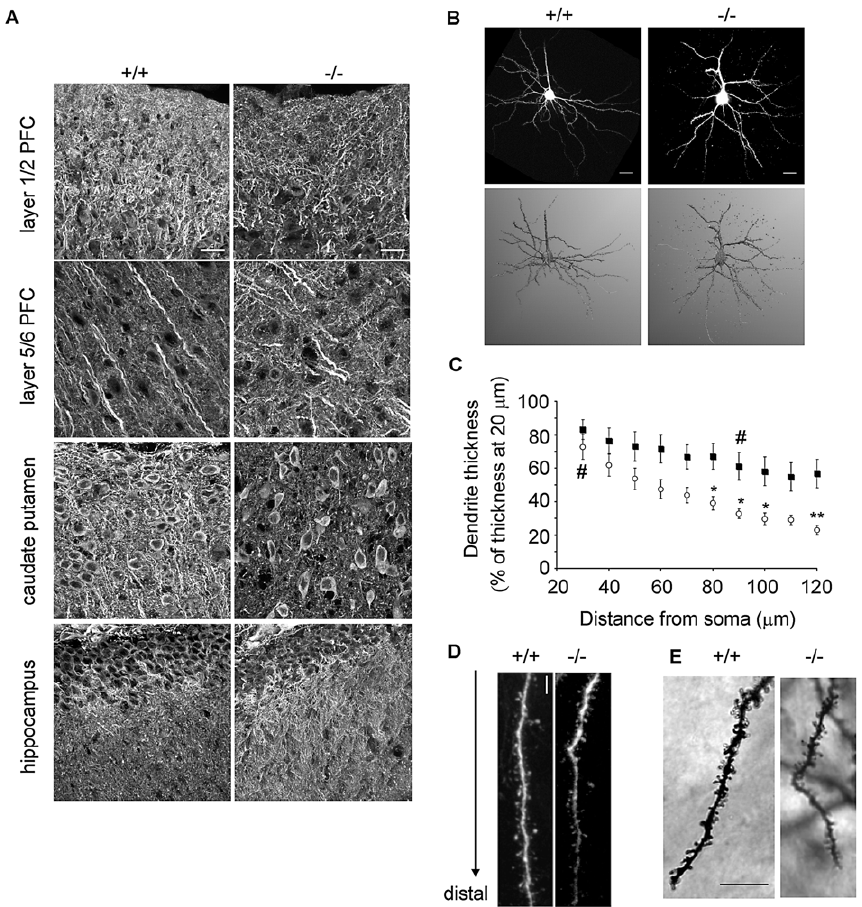
Figure 4. Abnormal dendritic morphology in b -III spectrin 2 / 2 mouse compared to wild type. A. Sagittal sections immunostained for MAP2 show irregular reactivity throughout prefrontal cortical layers and caudate putamen/striatum of 6-week-old b -III spectrin knockout ( 2 / 2 ) mice compared to wild type ( + / + ) but normal staining within hippocampus (N=3 each genotype; Bar, 20 m m). B. Top, Representative images of pyramidal neurons in layer 2/3 prefrontal cortex from 8-week-old WT and b -III spectrin knockout mice filled with Alexa 568 (Bar, 20 m m). Bottom, Neuronal 3-D reconstruction over laid using NeuronStudio software. C. Quantification of basal dendrite morphological parameters measured from reconstructed images shows greater distal thinning of dendrites in cells from b -III spectrin knockout mice (open circles; N=9) compared with WT cells (filled squares; N=8). All data are mean 6 SEM (* denotes significance between groups and # significance within a group.) D. High magnification image of single basal dendrite showing distal thinning in b -III spectrin knockout compared to WT but presence of normal spines (Bar, 5 m m). E. High magnification image of Golgi impregnated pyramidal neuron from prefrontal cortex of WT and b -III spectrin knockout mice (Bar, 10 m m). doi:10.1371/journal.pgen.1003074.g004 (Figure 5A) or an anti-tau antibody (Figure 5B). Similarly width of corpus callosum, measured from coronal sections immunostained for MBP (Figure 5C), was no different between WT and knockout animals ( + / + , 469.7 6 46.6; 2 / 2 , 480.6 6 41.3 m m, N= 3 for each genotype; p = 0.28).